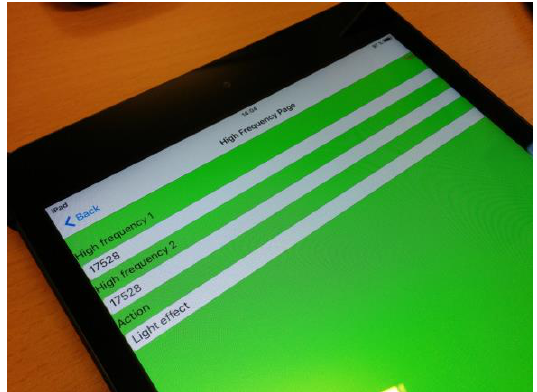
Figure 3. Second prototype version of the app displaying recognised control signals